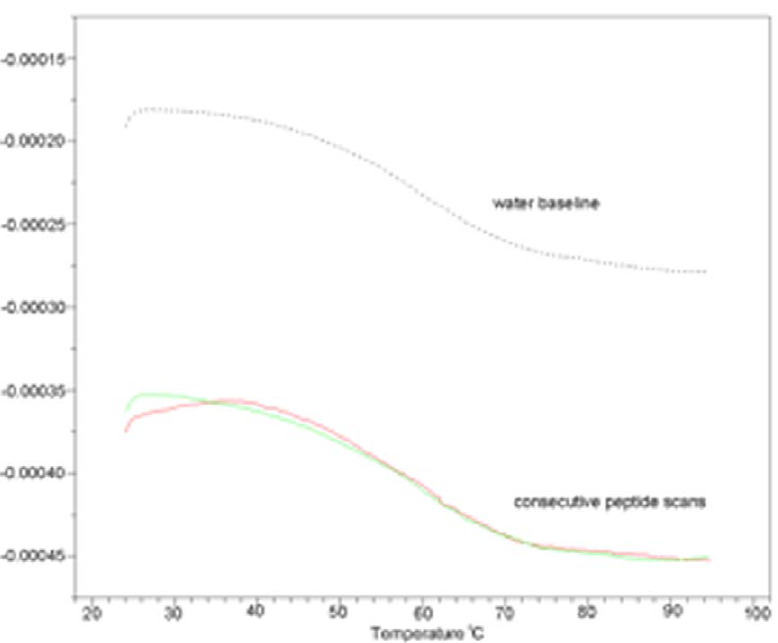
Figure 7. Differential scanning calorimetry of 1.0 mg/ml peptide in water. Heat capacity of solution is shown as a function of temperature. The instrument water baseline is shown together with the thermograms obtained during two consecutive upward temperature scans.